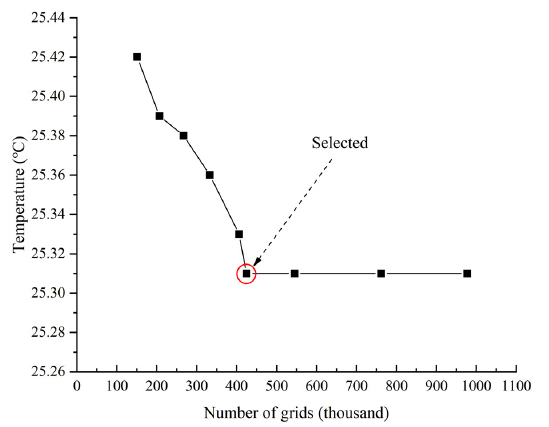
Figure 3. The independent grid test of the original base computer room.